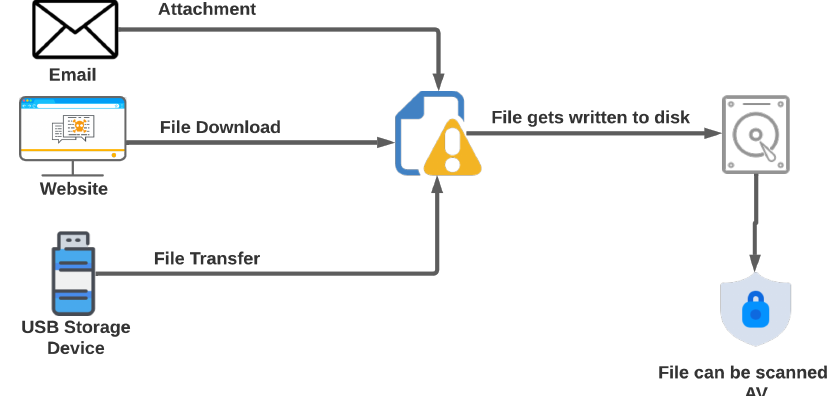
Figure 1. File-based malware infection chain (how malware infects the victim machine).